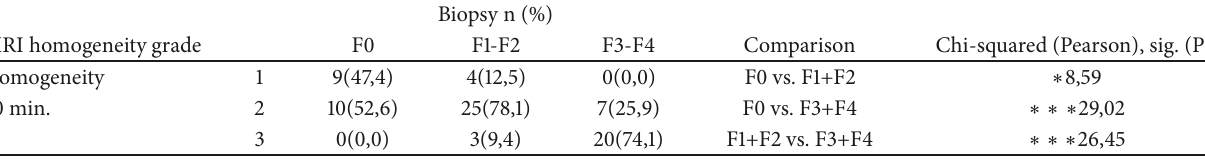
Table 4: The differences of liver homogeneity at 20 minutes post-Gd-EOB-DTPA injection among different categories of fibrosis.